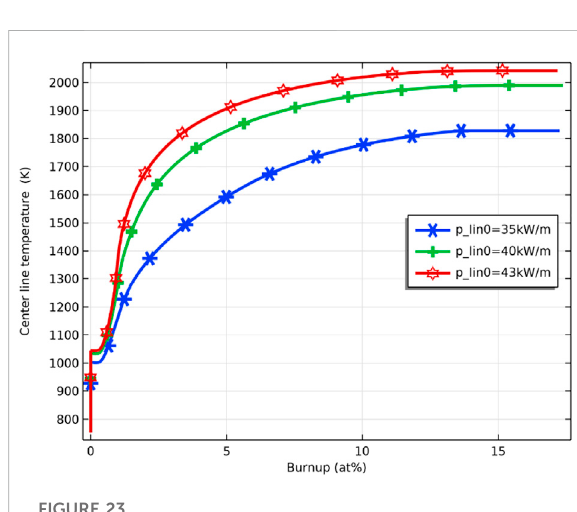
FIGURE 23 Variation of pellet inner surface temperature at initial linear power of 35 kW/m, 40 kW/m and 43